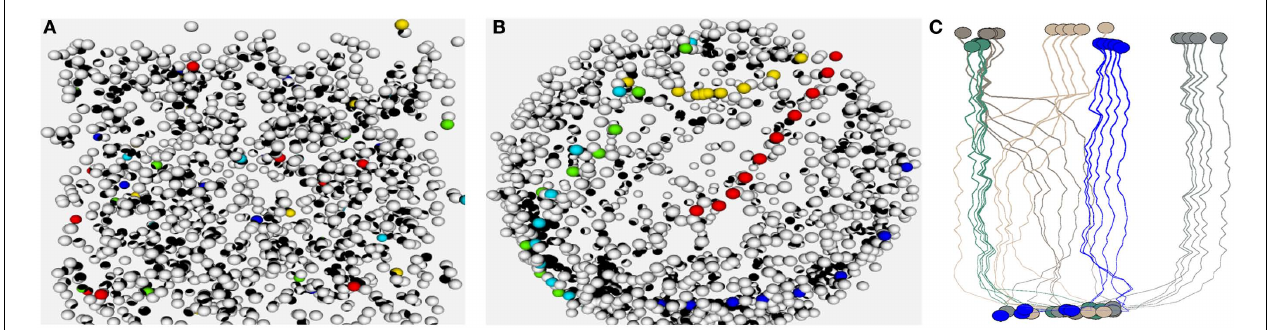
ORNs of a certain type (indicated by color) cluster together. Subfigure (C) is an illustration of how olfactory axons project from epithelium (bottom) to glomeruli (top) in a small network consisting of five OR types and five ORNs per type. Colors indicate OR